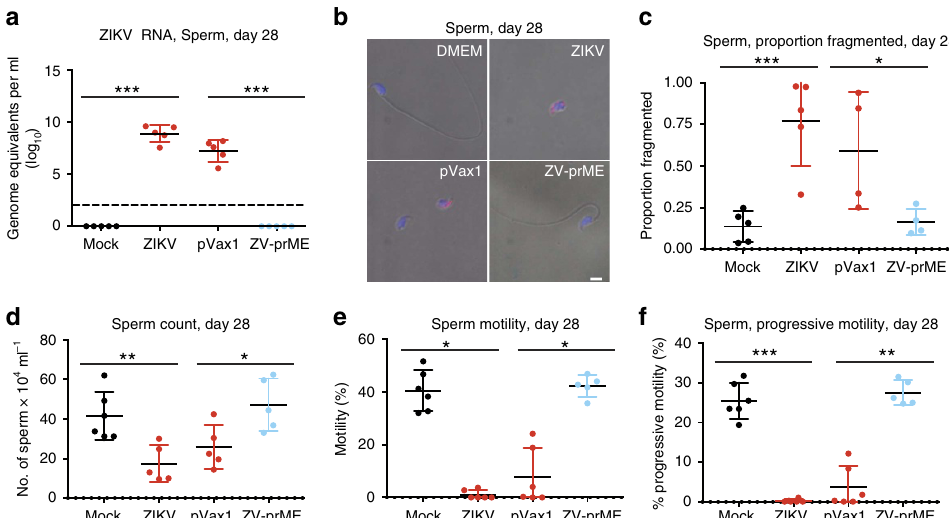
Figure 4 | Protection from ZIKV-induced sperm damage by DNA immunization. Five- to six-week-old male Ifnar1 (cid:2) / (cid:2) mice received two vaccinations by the i.m. route with electroporation-mediated delivery at 2-week intervals with 25 m g of the control vector (pVax1) or ZIKV-prME DNA vaccine (ZV-prME). Mice were challenged 2 weeks after the second immunization with a total of 1 (cid:3) 10 6 p.f.u. of ZIKV strain PRVABC59 by a subcutaneous route (s.c.) and compared to age-matched PBS mock-infected or ZIKV-infected mice. Sperm form the caudal epididymis was collected immediately after euthanization. ( a ) ZIKV RNA copies in the caudal sperm of mice measured by qRT-PCR ( n ¼ 5). Results are expressed as genome equivalents per ml. The horizontal hatched line indicates the limit of detection ( o 100 copies per ml). ( b ) Immunofluorescence analysis of caudal sperm with anti-ZIKV antibody. Blue indicates DAPI staining and red represents ZIKV. ( c ) The proportion of fragmented sperm was assessed following staining with Diff-Quick solution ( n ¼ 4). ( d – f ) Fertility parameters of caudal sperm were assessed ( n ¼ 5), including concentration ( d ), percentage motility ( e ) and progressive motility ( f ). Scale bars, 2mm in b . The data shown are from one experiment ( n ¼ 6) that is representative of the same outcome in the two studies performed. Bars indicate mean values and error bars indicate s.d. Statistical differences are given ( a , c – f , one-way ANOVA followed by Dunnett’s test. * P o 0.05; ** P o 0.01; *** P o